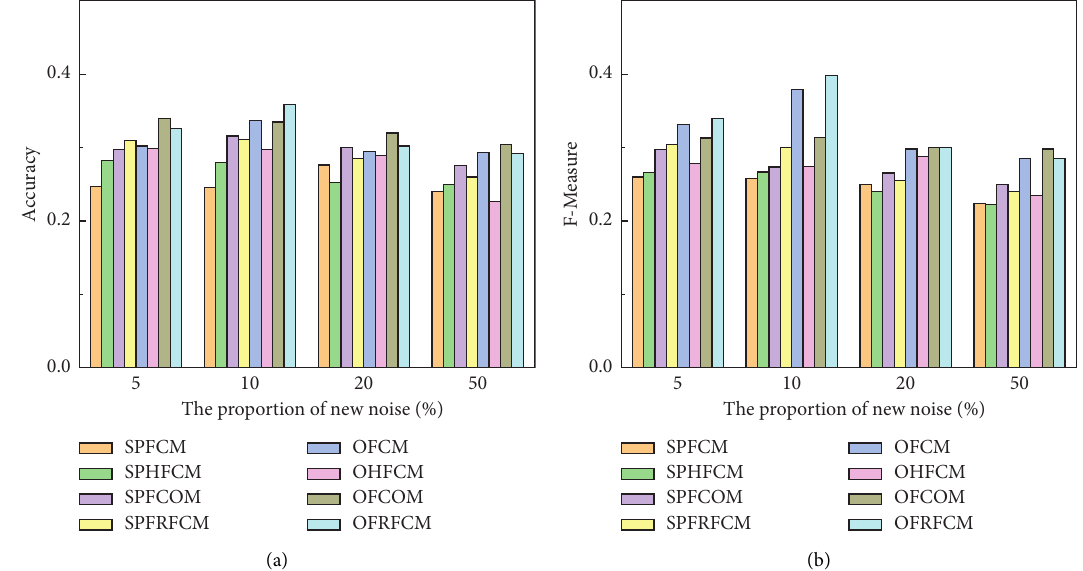
Figure 5: Robustness comparison on the WR dataset. (a) Accuracy; (b)